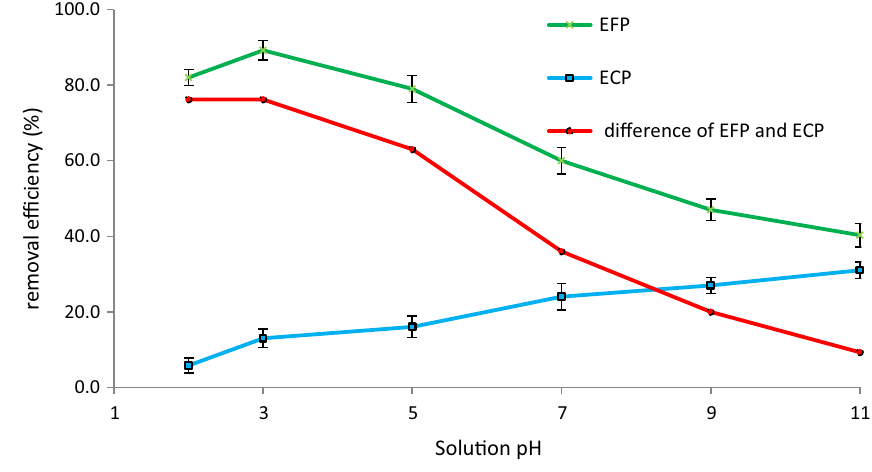
Fig. 3 Effect of solution pH on MG degradation in EFP and ECP (initial MG concen- tration = 200 mg/L; current density = 7.5 mA/cm 2 ; H 2 O 2 dosage = 50 mg/L; reaction time = 10